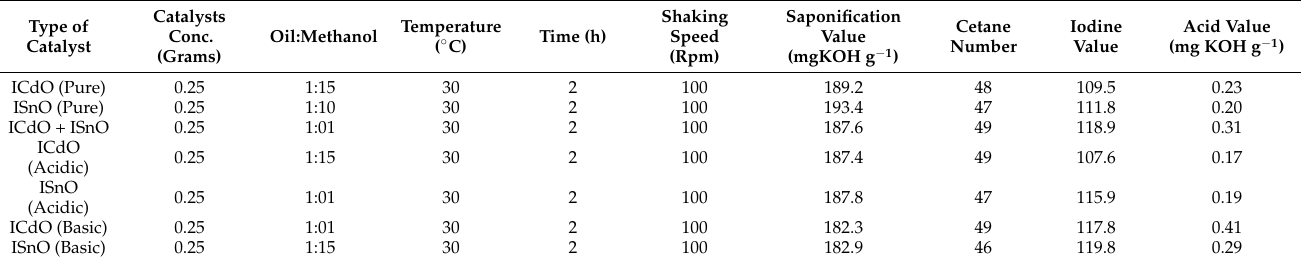
Table 2. Quality parameters of biodiesel samples at varied reaction